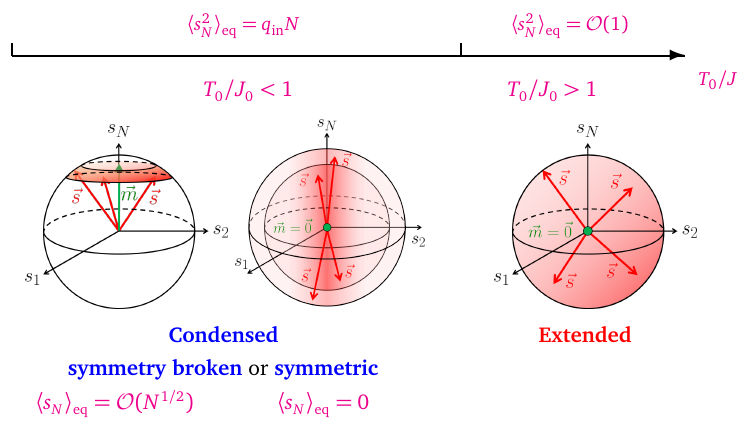
Figure 1: The three kinds of initial conditions. Symmetry broken and symmetric / J < 1, which we call condensed because of 〈 s 2 for T 0 0 〉 = ( 1 ) for T / J ≥ 1. The (green) vector (cid:126) m represents the symmetry with 〈 s 2 eq 0 0 N O broken direction, while the (red) arrows (cid:126) s indicate different realisations of the initial